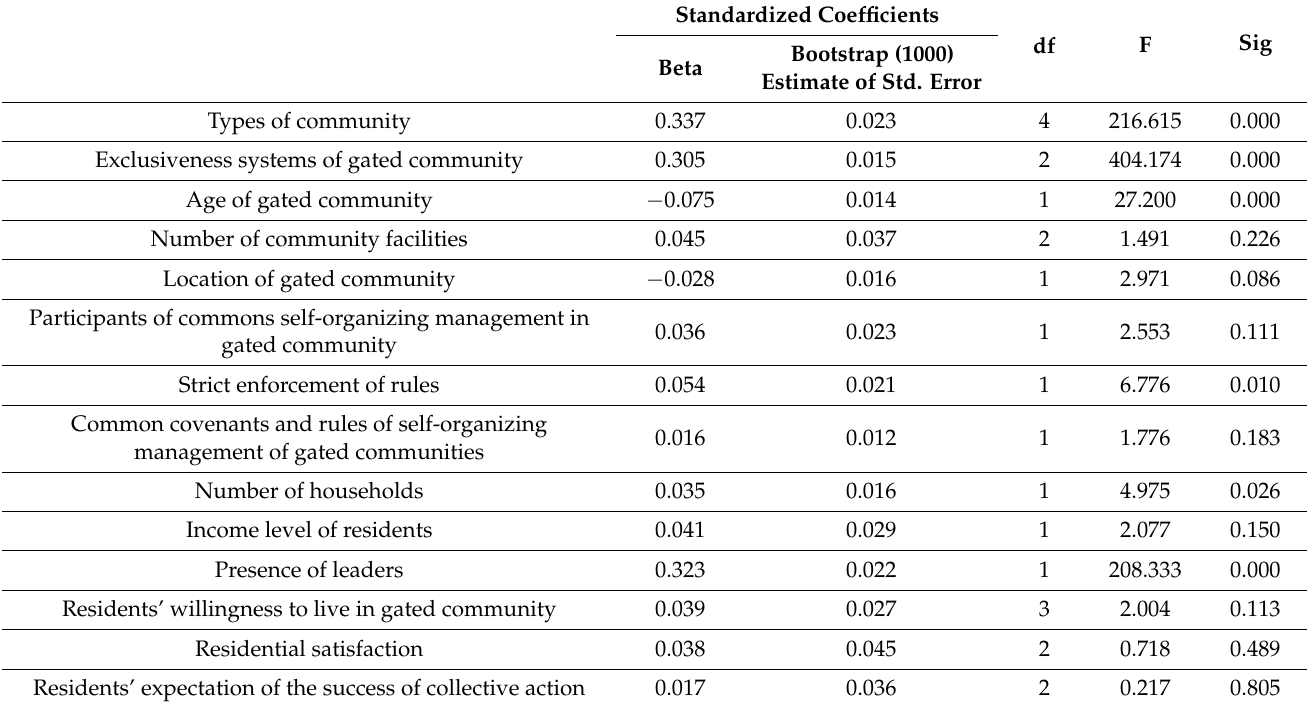
Table 10. Regression coefficients (Dependent variable: Residents’ collective action